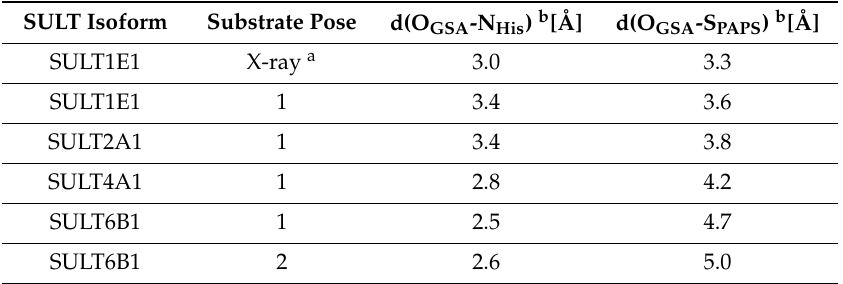
Table 2. Distances of the hydroxy moiety of GSA in the binding modes suggested by